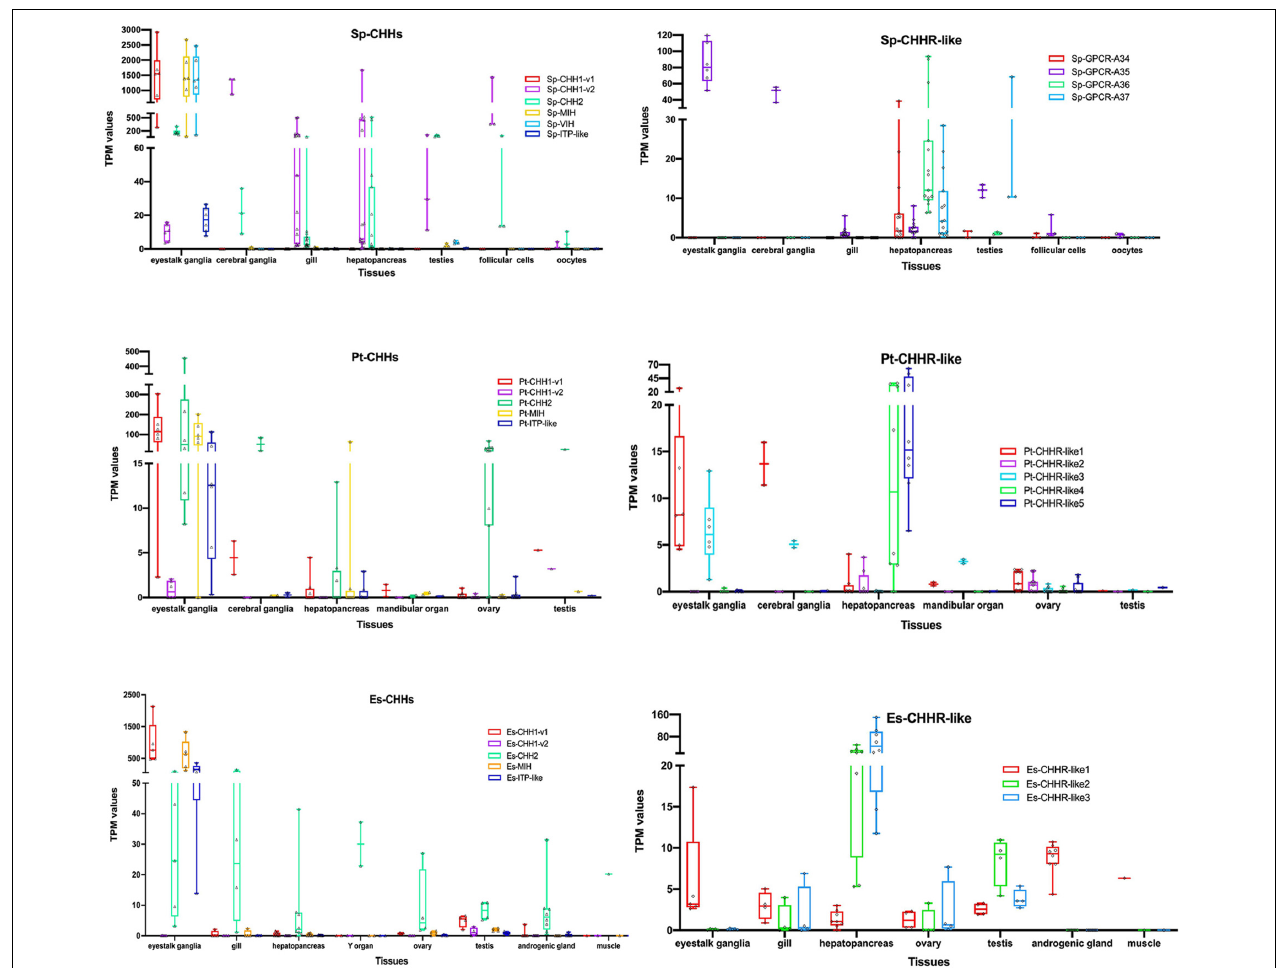
FIGURE 6 | Expression patterns of CHHs and their putative GPCRs. CHHs and their putative GPCRs expressions from different RNA-seq in S. paramamosain, P. trituberculatus and E. sinensis . The boxplot consists of the minimum and maximum range values. The upper boundary of the box indicates the 75th percentile and the lower boundary of the box indicates the 25th percentile, the line in the box is the median. Whiskers above and below the box indicate maximun value and minimun value, respectively. Each triangle or diamond symbol in the box indicates one sample. More sample sources were deposited in Supplementary Material